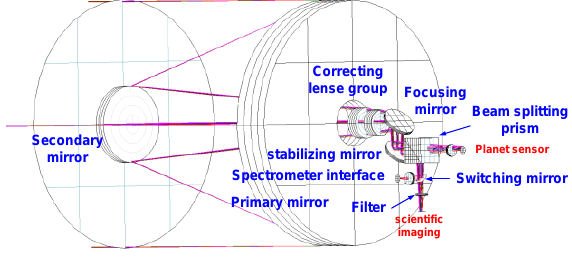
Figure 2 Optical system design result